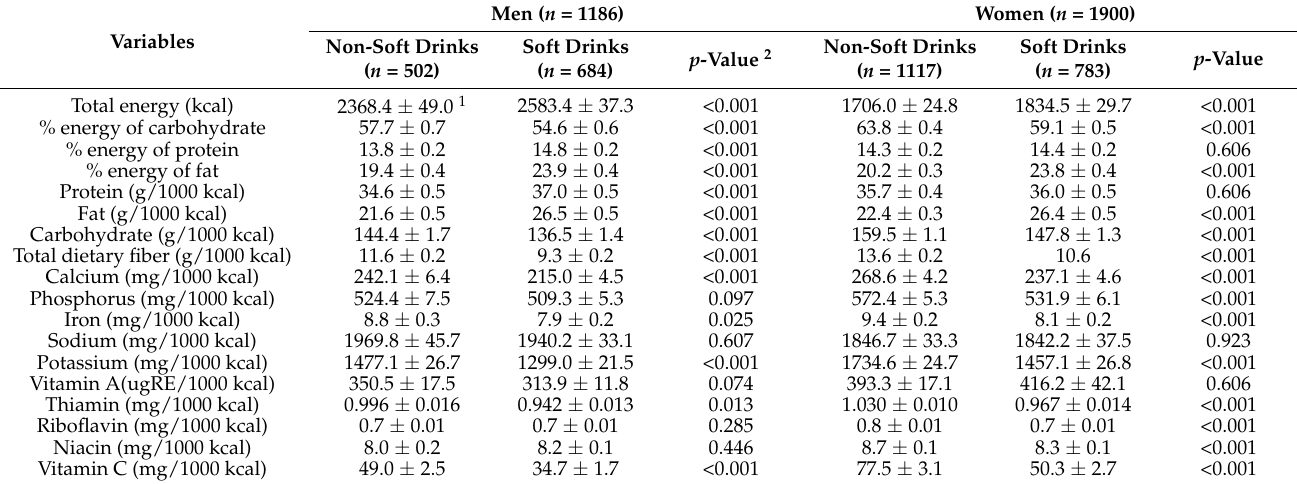
Table 3. Participants’ nutrient intake according to frequency of soft-drink intake by